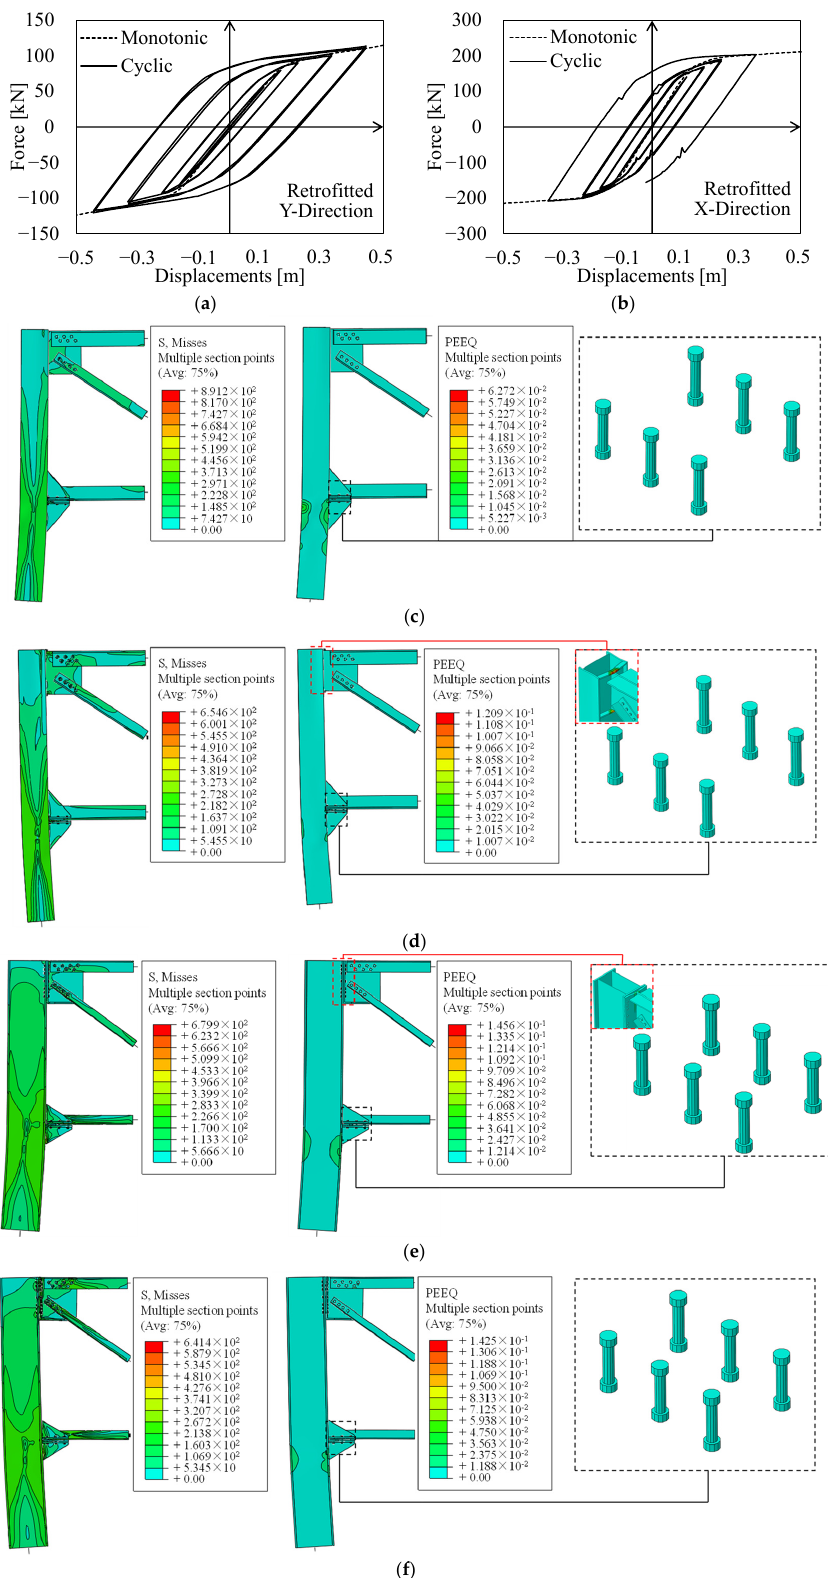
Figure 14. Local performance of retrofit interventions in terms of base shear vs. displacement curves and distributions of MISES and PEEQ. ( a ) Base Shear vs. Displacements (X); ( b ) Base Shear vs. Displacements (Y); ( c , d ) Von Mises and PEEQ distribution of MR truss in X direction under hogging and sagging actions; ( e , f ) Von Mises and PEEQ distribution of MR truss in Y direction under hogging and sagging actions.